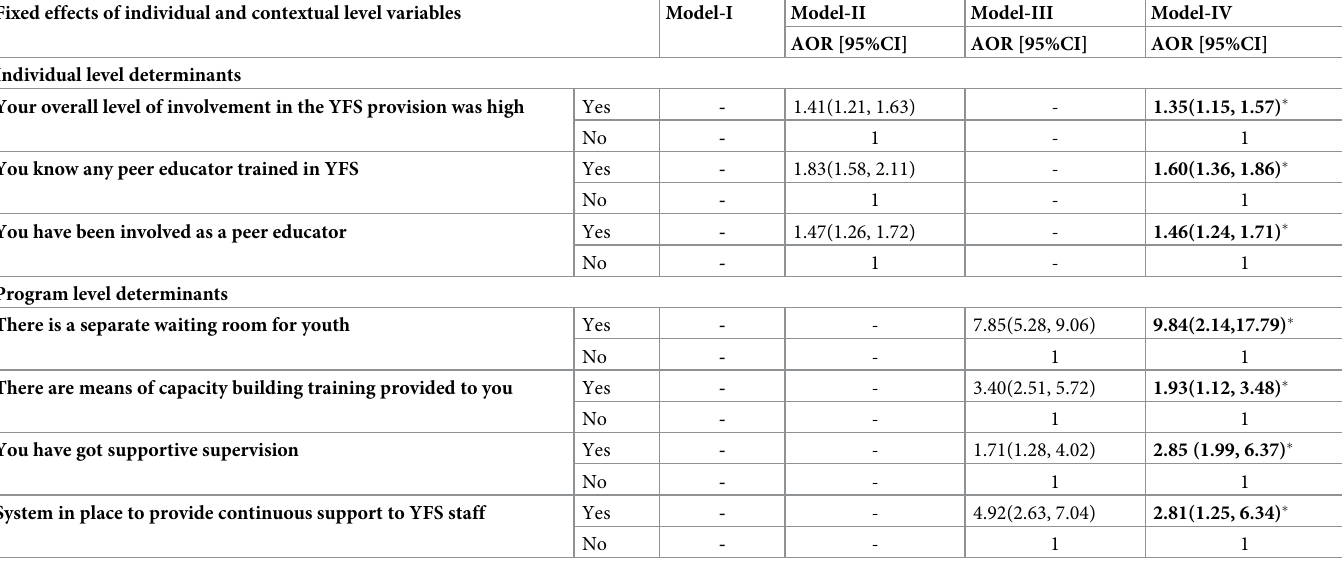
Table 6. Bivariable and multivariable multi level logistic regression analysis of individual and contextual determinants of implementation fidelity of YFS, North- west Ethiopia, 2019. Fixed effects of individual and contextual level